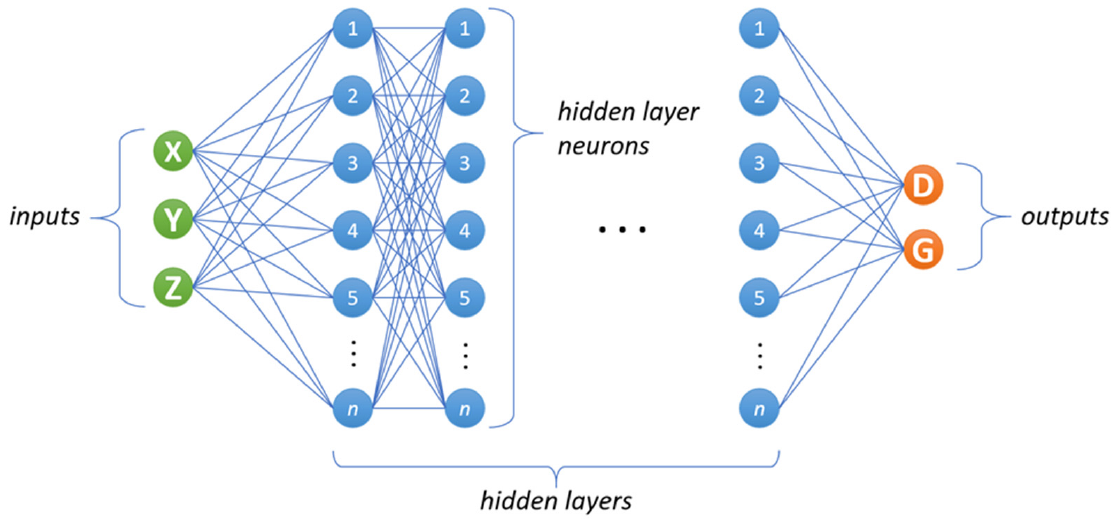
Figure 3. Simplified architecture of the artificial neural network used for domain modelling [5].